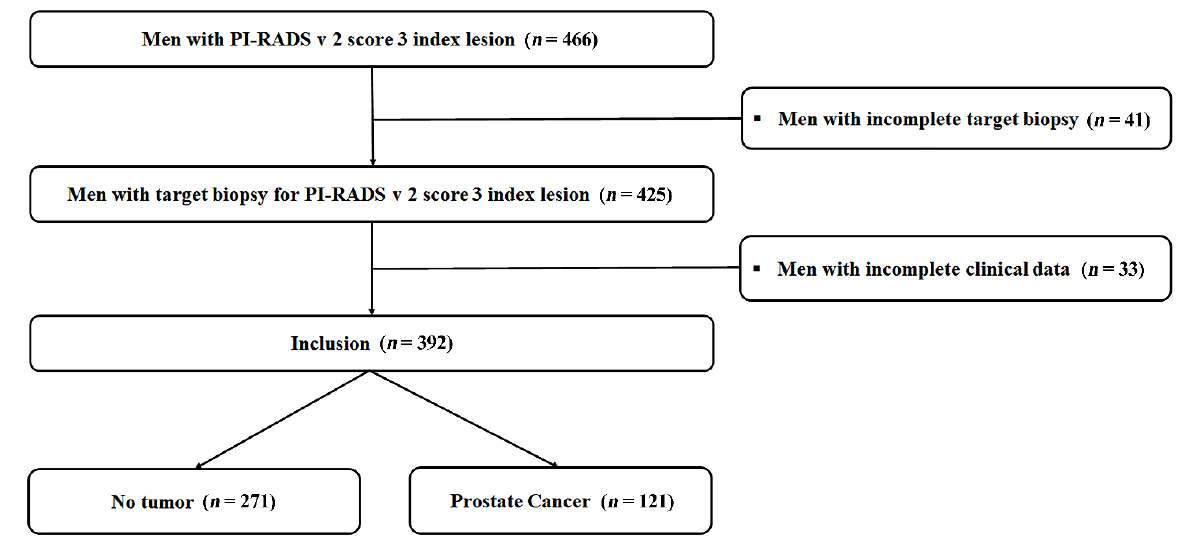
Figure 1. Flowchart of the study.